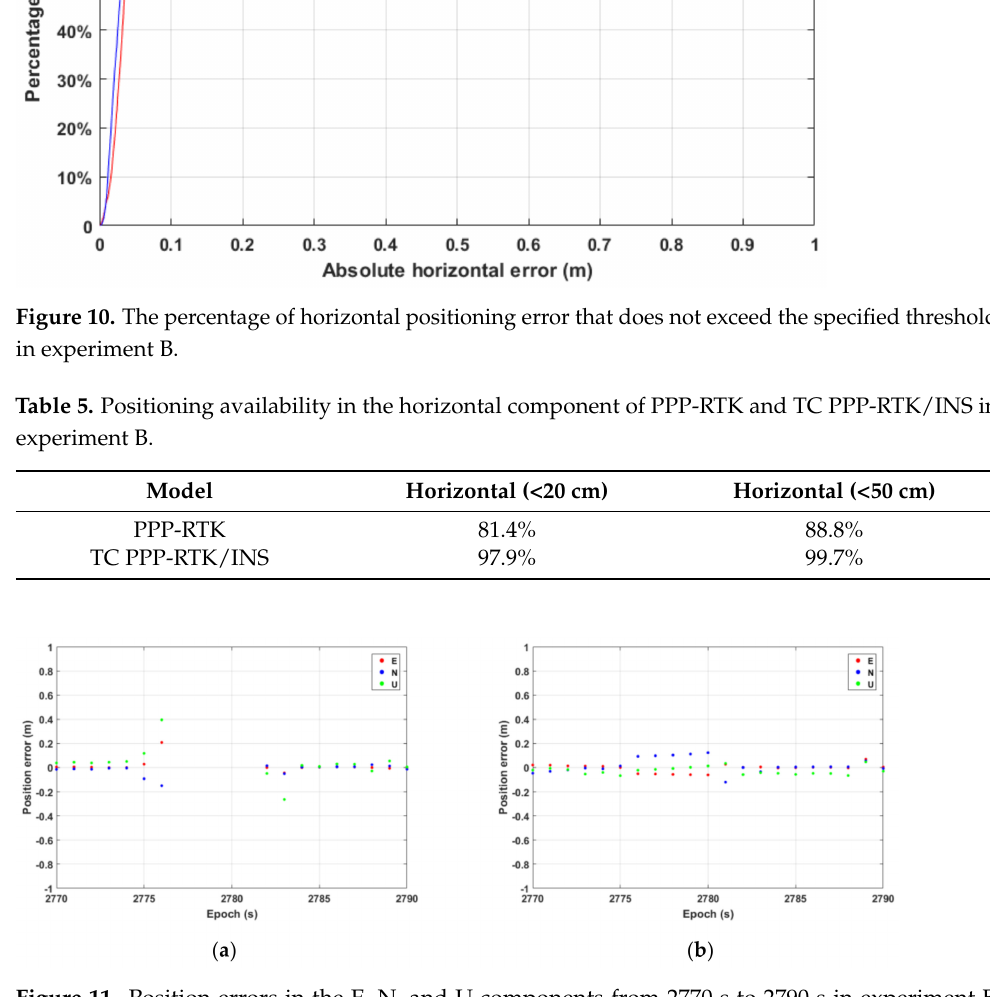
Figure 11. Position errors in the E, N, and U components from 2770 s to 2790 s in experiment B. ( a ) PPP − RTK. ( b ) TC PPP −